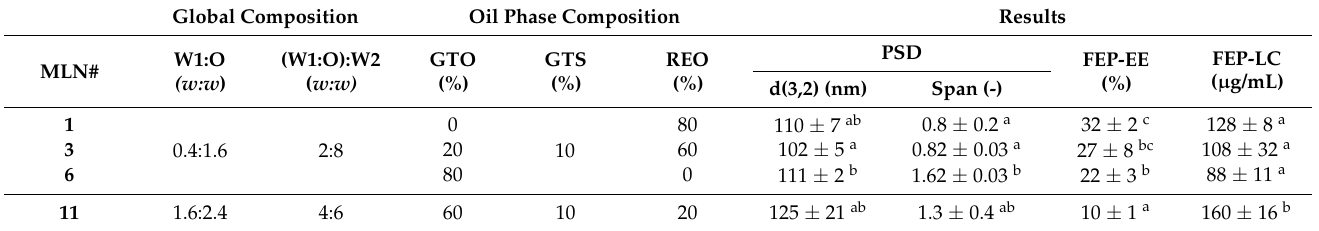
Table 3. Effect of mass phase ratios and lipid composition on REO-FEP- and FEP-MLN physicochemical properties. Global Composition Oil Phase Composition